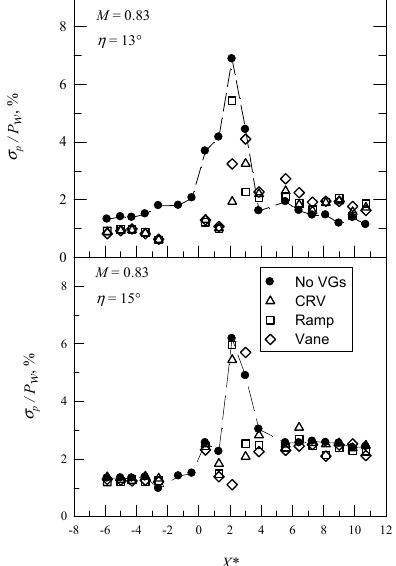
(Figure 13), CRV MVGs are the most effective at control for SIBLS. Ramp MVGs are less effective because the vortices are weaker and there is rapid lift-off from the surface [27]. Lee and Loth [30] determined that streamwise vortices are sustained at greater Mach num- bers. The onset of flow separation occurs farther downstream for M = 0.89 but the MVGs are still effective to mitigate surface pressure fluctuations.